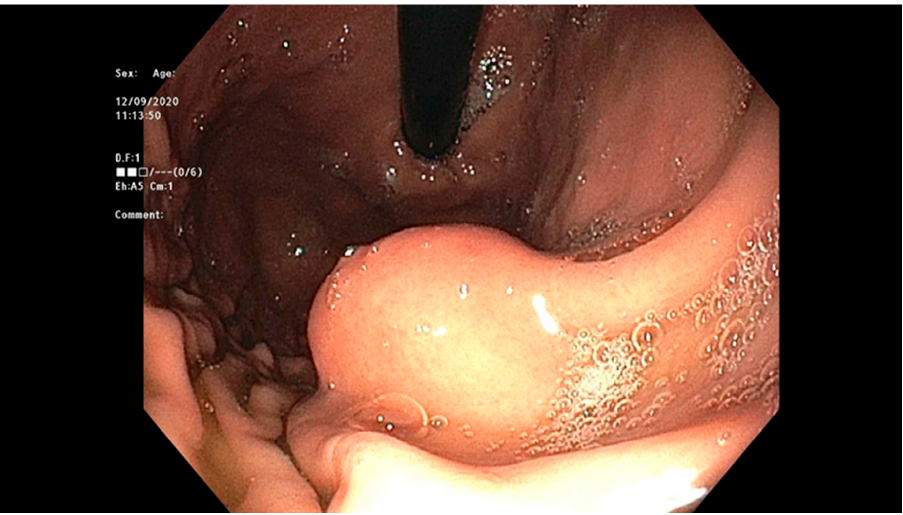
Figure 12. Gastrointestinal stromal tumor, as seen with high-definition white light endoscopy.